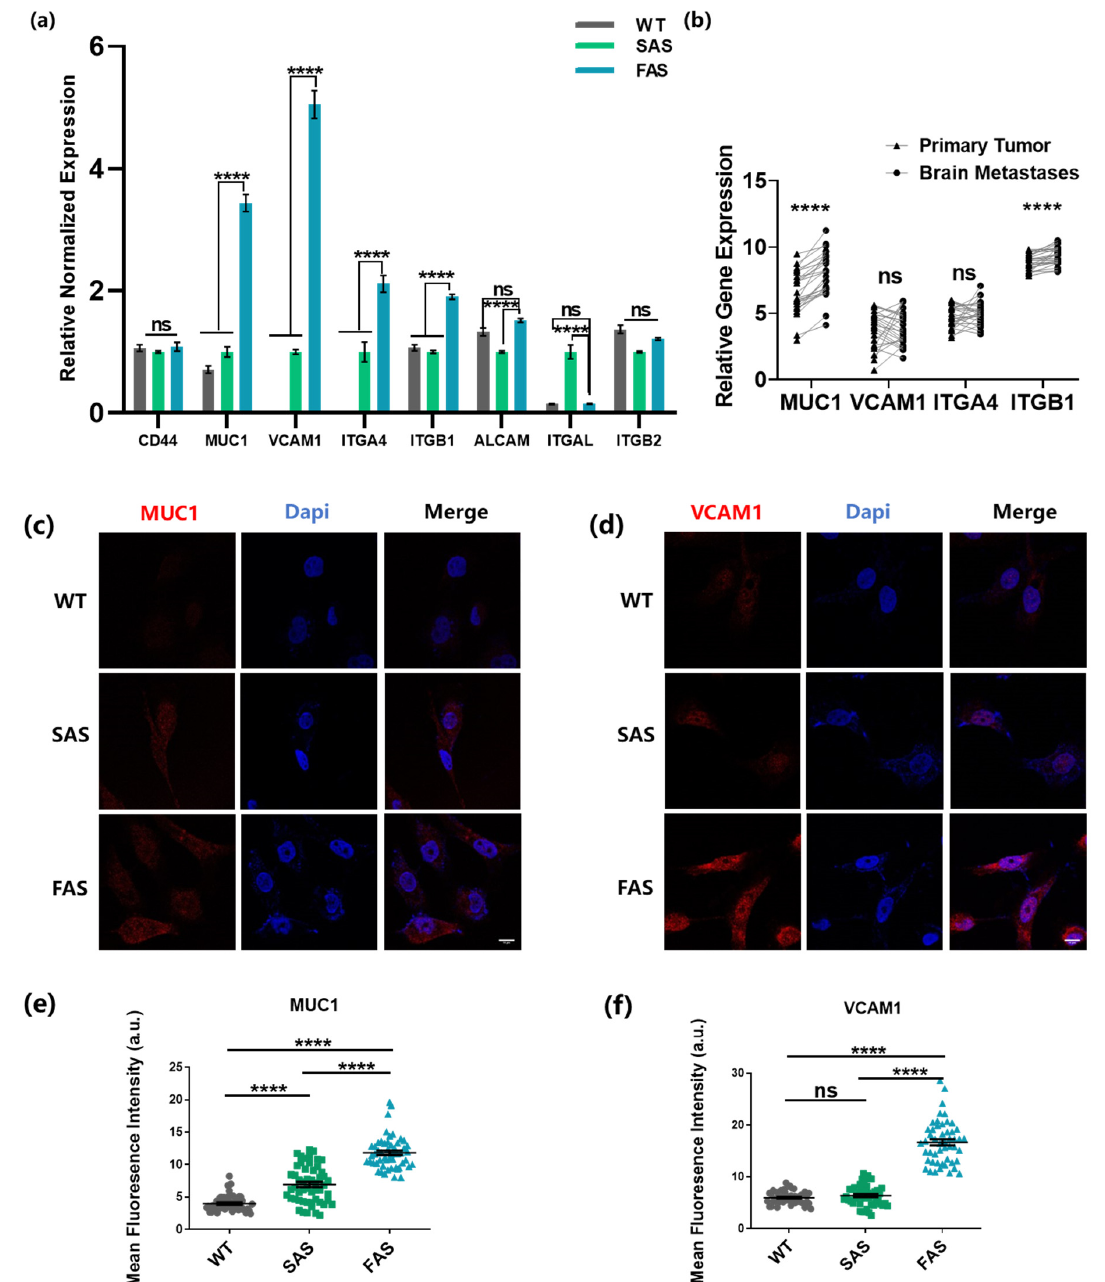
Figure 5. The FAS cells up-regulate multiple adhesion molecules that are clinically relevant to breast cancer brain metastasis. ( a ) FAS cells had enhanced expressions of brain metastasis-related adhesion genes. qPCR was conducted to test the gene expression. The statistics were analyzed based on two-way ANOVA along with the post hoc Tukey test. n = 3. ( b ) The highly expressed adhesion molecules in the FAS cells were clinically related to brain metastasis. The gene expression data were collected from the GEO public database (GSE173661, n = 25 samples). The paired comparison was analyzed using Graphpad. For each gene, a paired Student’s t -test was used to analyze the difference between the statistics in two groups. ( c , d ) The expressions of MUC1 and VCAM1 were tested through immuno fl uorescence staining. Scale bar = 10 µm. ( e , f ) Quanti fi cation of the expressions of MUC1 and VCAM1 in ( c , d ). The statistics among three groups were calculated based on one-way ANOVA with the post hoc Bonferroni test. n = 50. All data are represented by mean ± SEM. (ns: no signi fi cance, **** p < 0.0001).